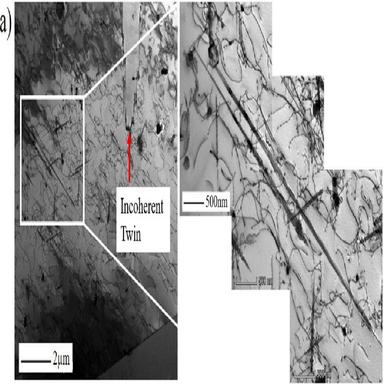
a) Panoramatic TEM images and b) Chemical Maps shows Stacking Fault after creep test of Alloy 709 under 150 MPa at 700 ◦C enriched in chromium according to Chemistem. White arrows pointing to some precipitates enriched in Nb, B, Ti, N, C, and S.